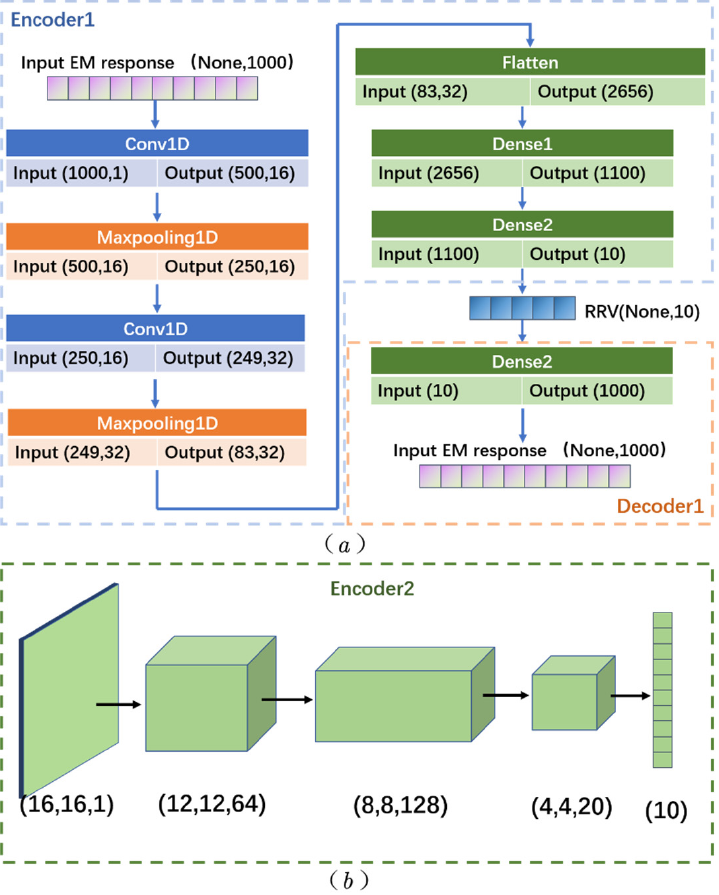
Figure 5. ( a ) The internal structure of encoder1, decoder1. ( b ) The internal structure of encoder2.